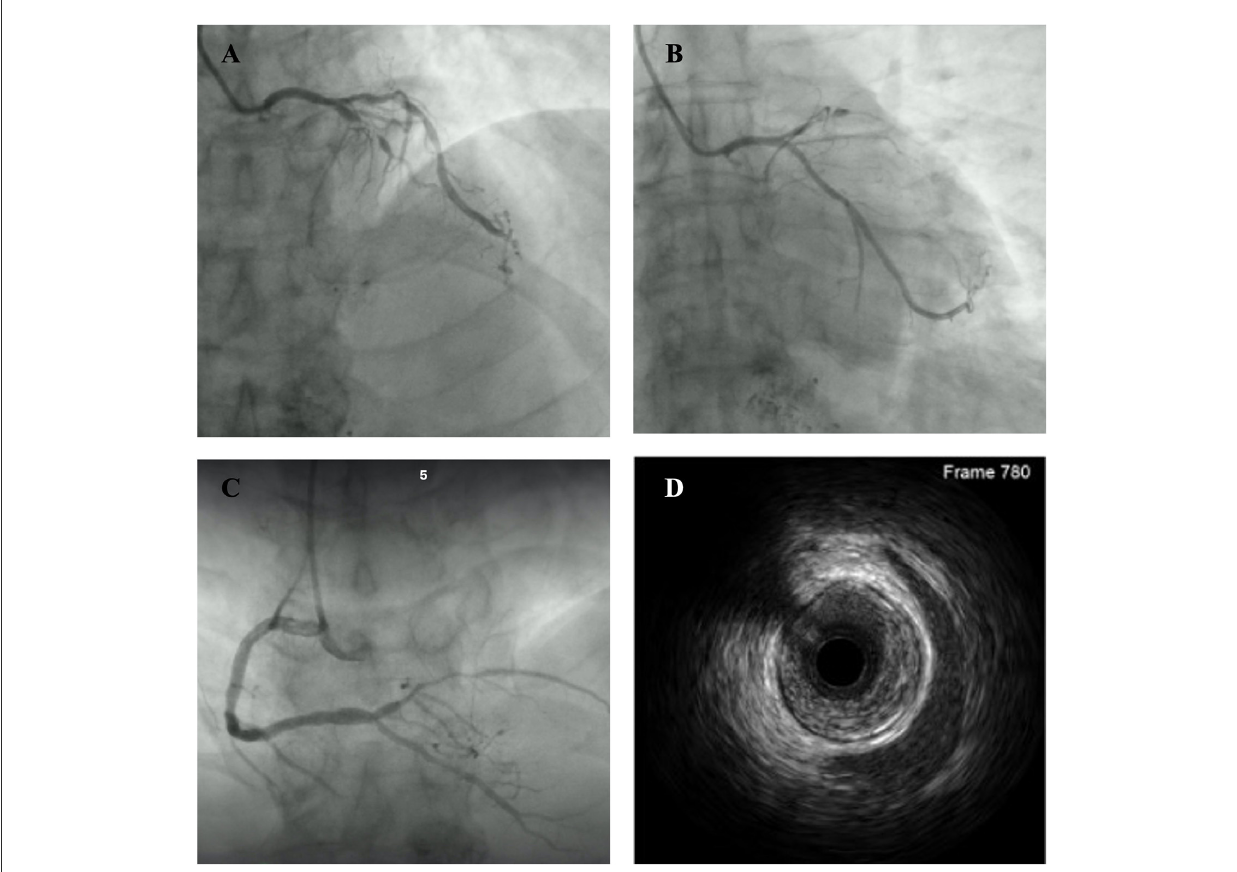
FIGURE2 Baseline coronary angiography at first admission showed a subtotal occlusion of the left anterior descending artery with thrombolysis in myocardial infarction 0–1 flow (A) , mild–moderate stenosis in the left circumflex artery (B) , and right coronary artery (C) . Intravascular ultrasound showed diffused atherosclerotic plaque in the left anterior descending artery (D)